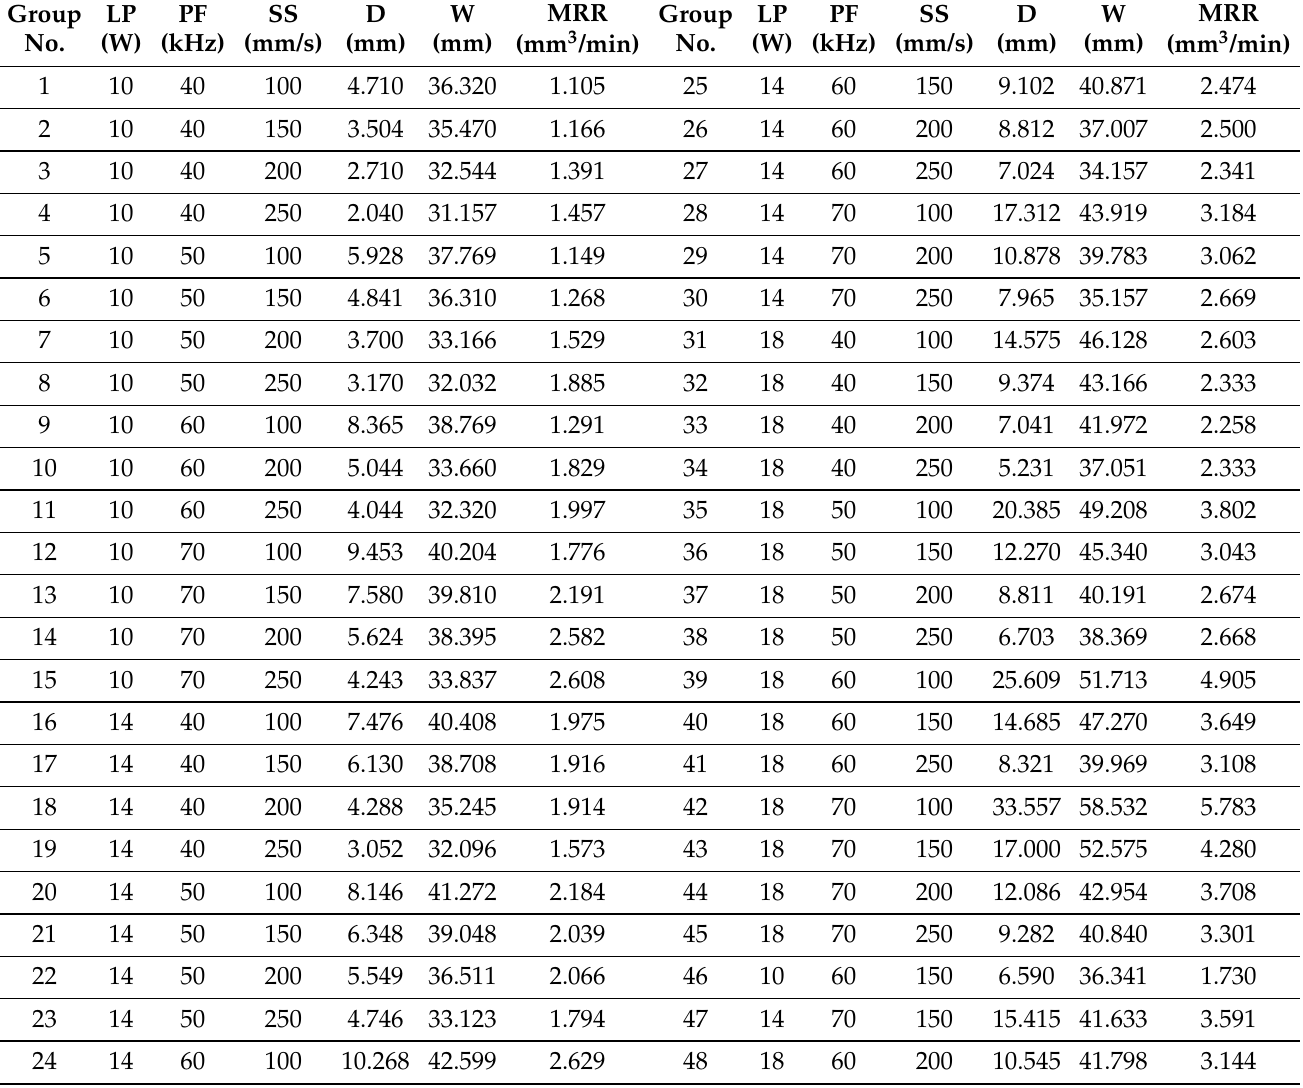
Table A1. The measurement results of the micro-groove